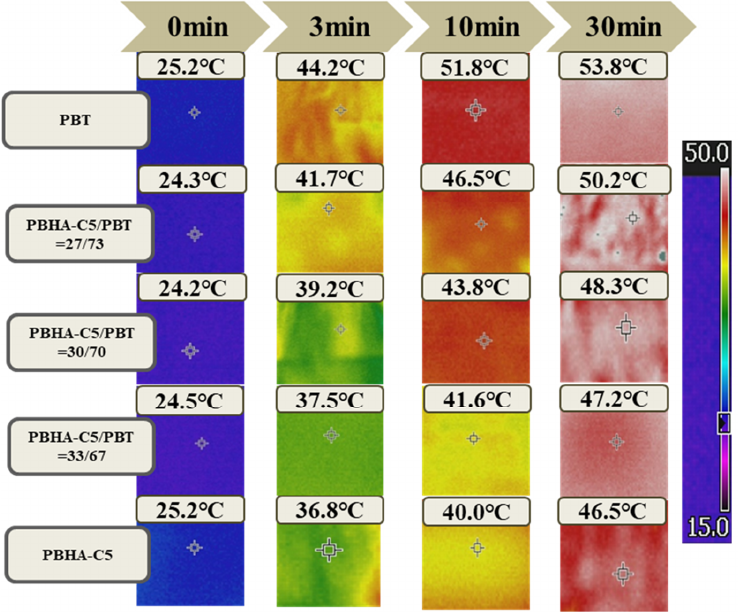
Figure 12. Infrared temperature image for neat PBT, blended fiber samples with 27, 30, 33 wt% PBHA-C5, and neat PBHA-C5 for different heating times at 55 °C.